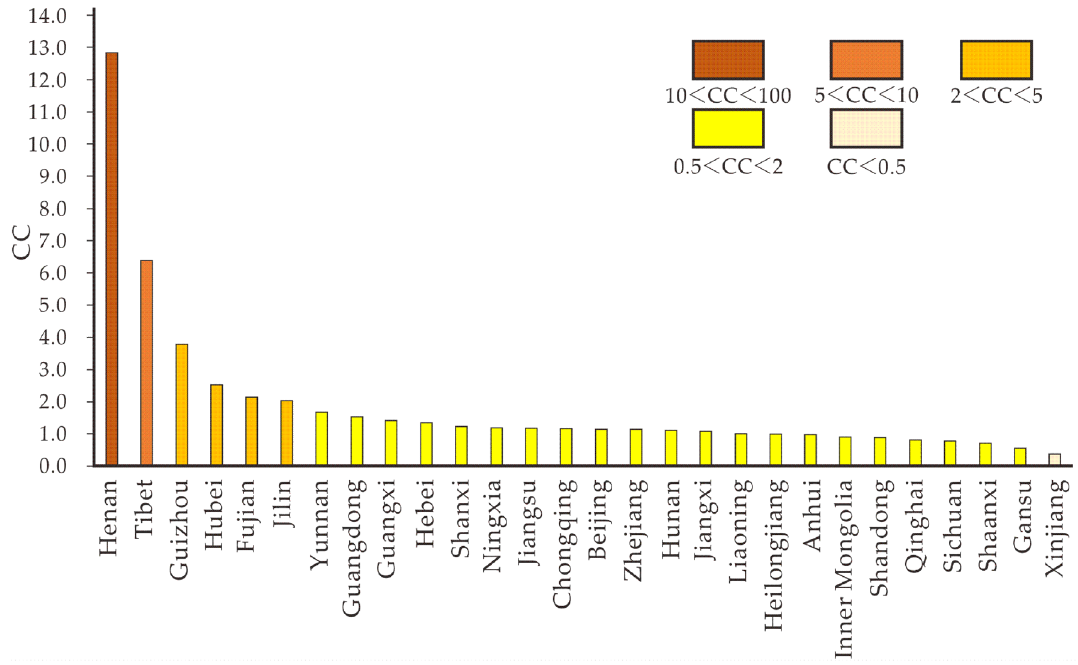
Fig. 2 CC values of lead in coals from different provinces in China. CC: Concentration coefficient. The lead value from Dai et al. (2012) of 15.1 l g/g was used as the reference value to determine the CCs. No data were available for Taiwan, Hong Kong, Macau, Hainan, Tianjin, and Shanghai